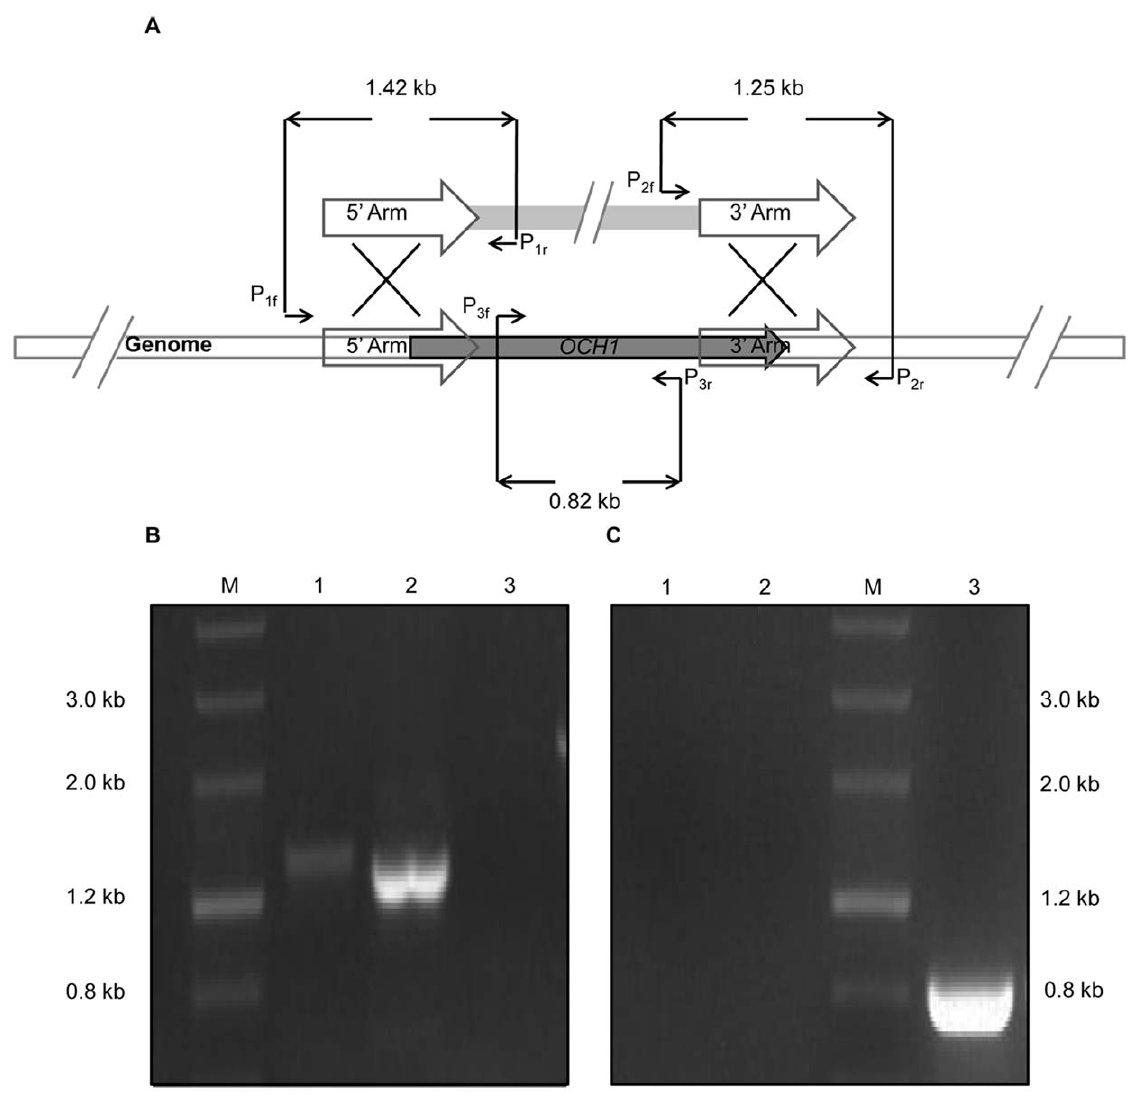
Figure 4. Verification of och1 mutant by polymerase chain reaction (PCR). A) Schematic representation of the OCH1 gene disruption and the primers used for verification. Three primer pairs were used. For the correct transformants, two bands with the size of 1.42 and 1.25 kb were amplified using the P 1f /P 1r and P 2f /P 2r primer pairs, respectively. No band was amplified using the P 3f /P 3r primer pair. B) Identification of och1 mutant by PCR with three primer pairs, P 1f /P 1r (Lane 1), P 2f /P 2r ,(Lane 2), and P 3f /P 3r (Lane 3). C) Pichia pastoris GS115 strain was used as a negative control for PCR verification by using the three primer pairs, P 1f /P 1r (Lane 1), P 2f /P 2r (Lane 2), and P 3f /P 3r (Lane 3; the expected size of the band is 0.82 kb).